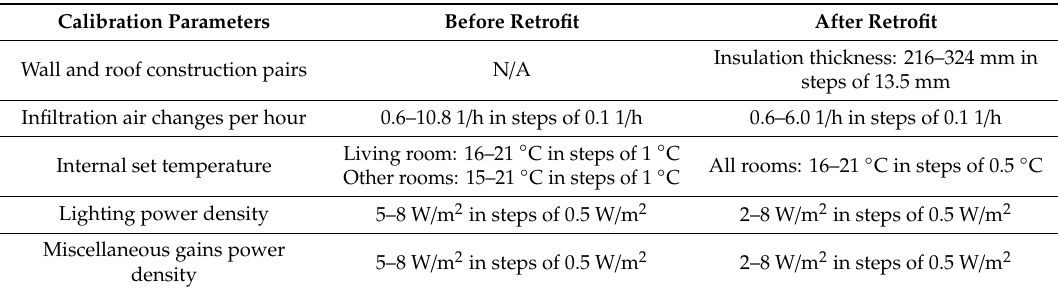
Table 7. Calibration parameters before and after the retrofit.